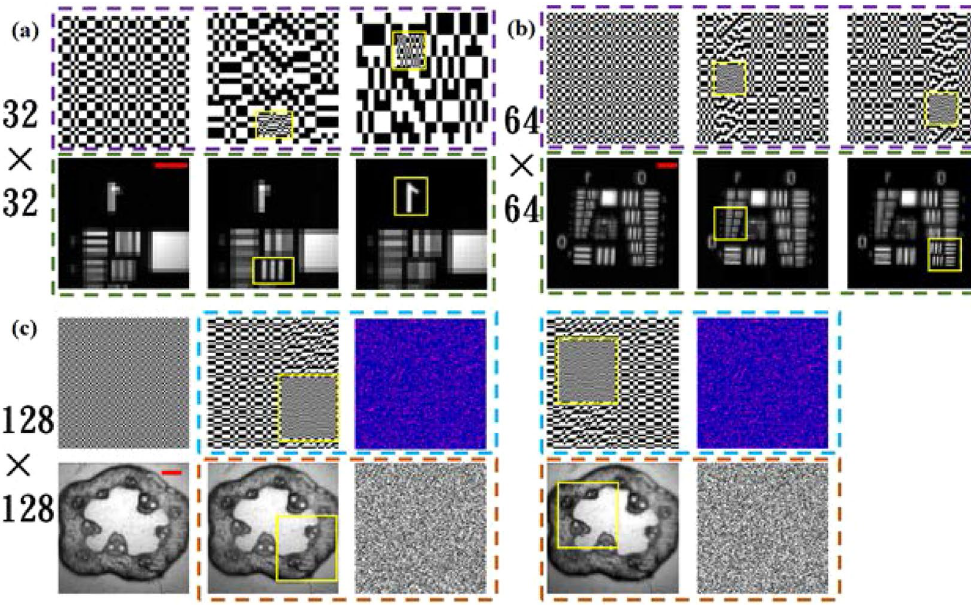
Figure 4. Imaging results for Experiment A. The area selected by the yellow box is where the ROI lies. The scale bar in red = 1 mm. ( a ) The number of light patterns based on the Hadamard matrix was 1024, and three kinds of light patterns and their corresponding imaging results are shown. ( b ) The number of light patterns based on the Hadamard matrix was 4096, and three kinds of light patterns and their corresponding imaging results are shown. ( c ) The target was crosscut pumpkin stems, and the number of the light patterns was limited to 16384. The image in the blue dotted frame is followed by a linearly mapped illumination pattern and a cipher pattern, and the corresponding red dotted frame image was the result of decryption using the correct cipher pattern and the result obtained using the wrong cipher